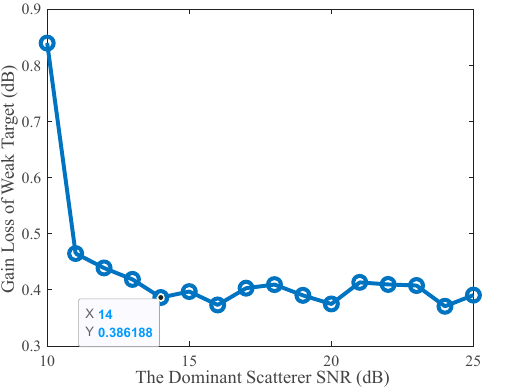
Figure 10. The synthetic SNR gain loss of the weak target versus the dominant scatterer’s SNR. In summary, the dominant scatterer in the paper can be defined as a medium- or long-range target that is close to the radar’s normal direction. Moreover, its SNR should be as higher than 13 dB as possible. According to these selection criteria, the selection procedure of the dominant scatterer in practice is illustrated in Figure 11.